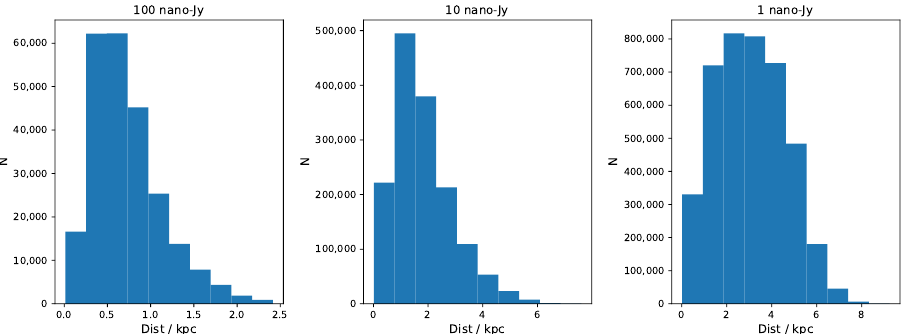
Figure 13. The distance distribution of M dwarf flares above different detection limits (100 nano-Jy, 10 nano-Jy, and 1